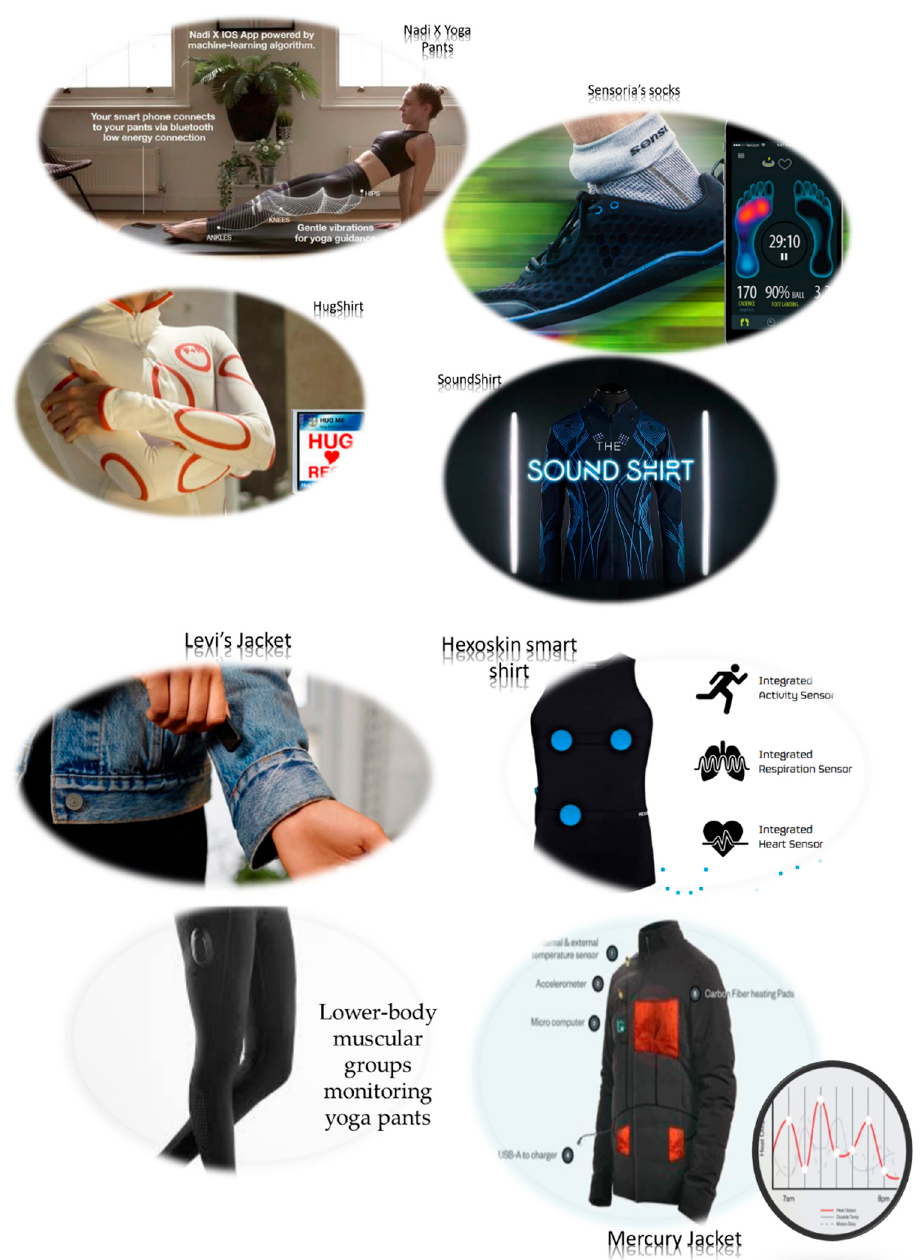
net Figure 13. Some examples of wearable electronic smart textiles. Images were taken from the Internet [72–79].